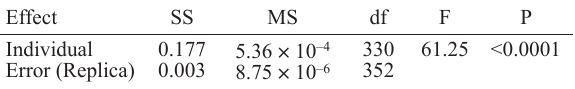
Table 2. – Main results of the Procrustes ANOVA between indi- viduals as main factor and replica as measurement